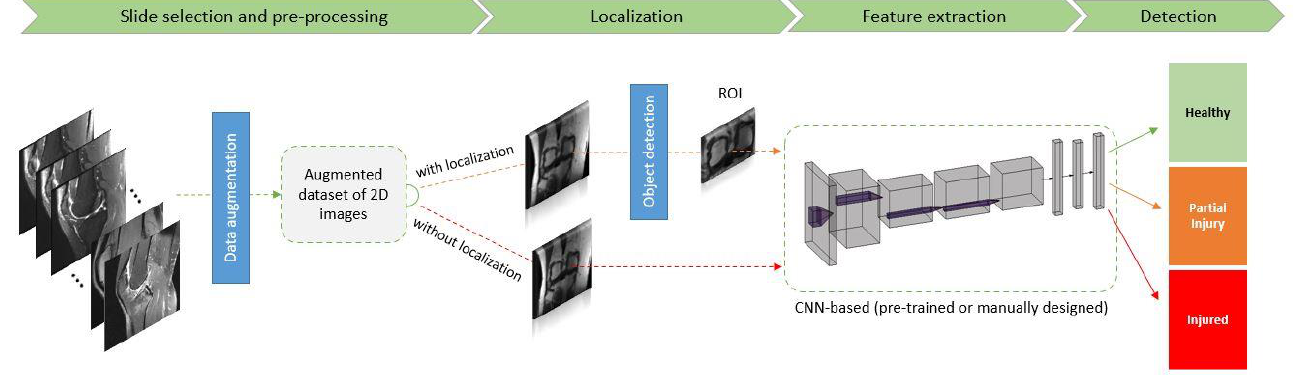
Figure 5. A typical DL pipeline for ACL